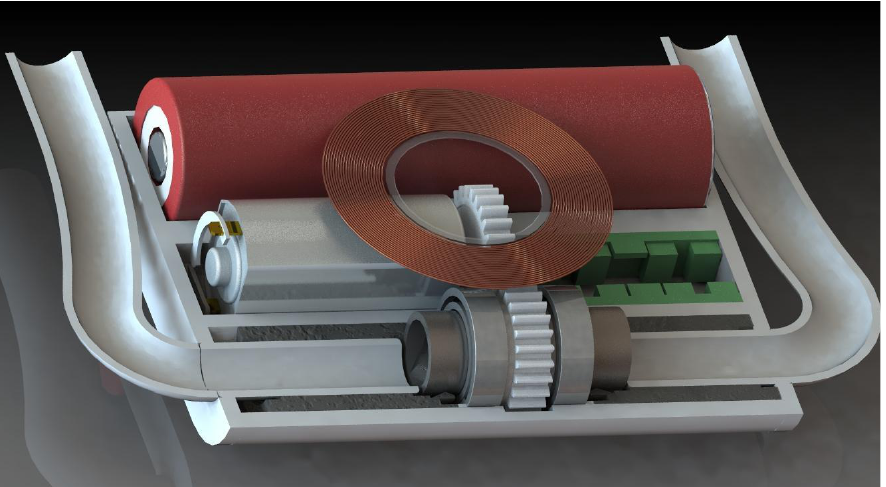
Figure 6. Longitudinal section through the implant including battery, motor, transmission, pump, antenna, suction, and discharge.